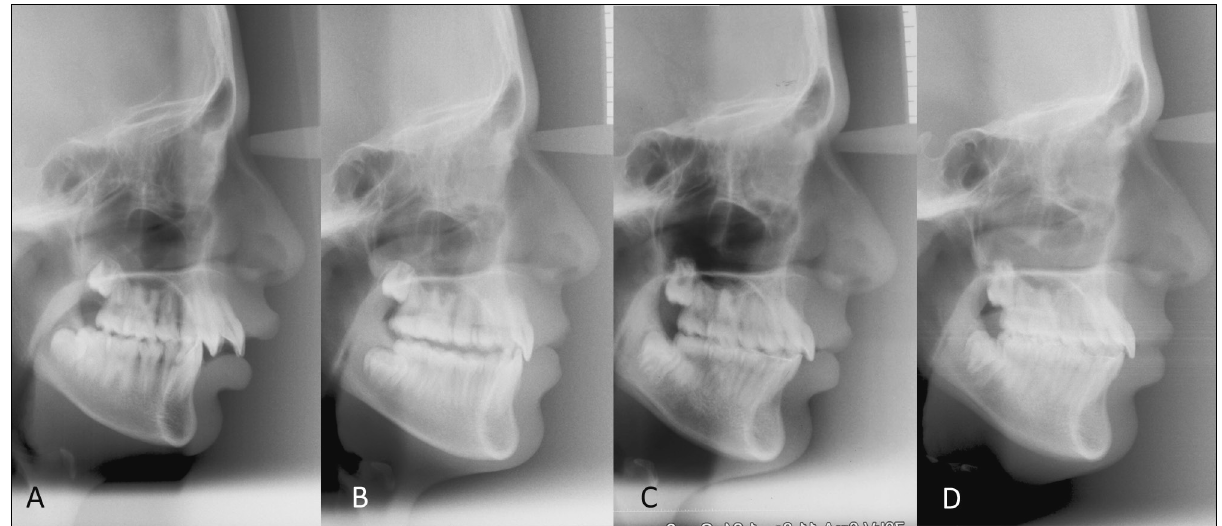
Figure 7. Lateral cephalograms showing growth and treatment changes. A. Pretreatment; B. Post-functional (8 months); C. Immediately post-debond (26 months); D. 2 ½ year post-functional/1 year post-treatment.